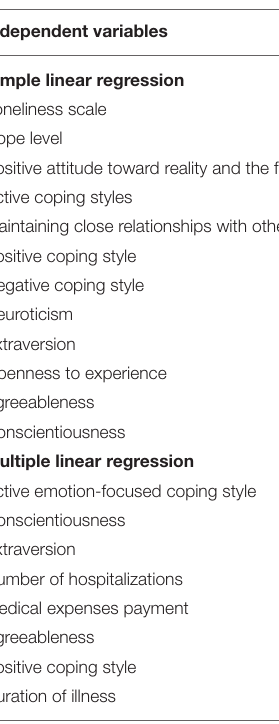
TABLE 2 | Linear regression results for factors associated with patient self-esteem ( n =